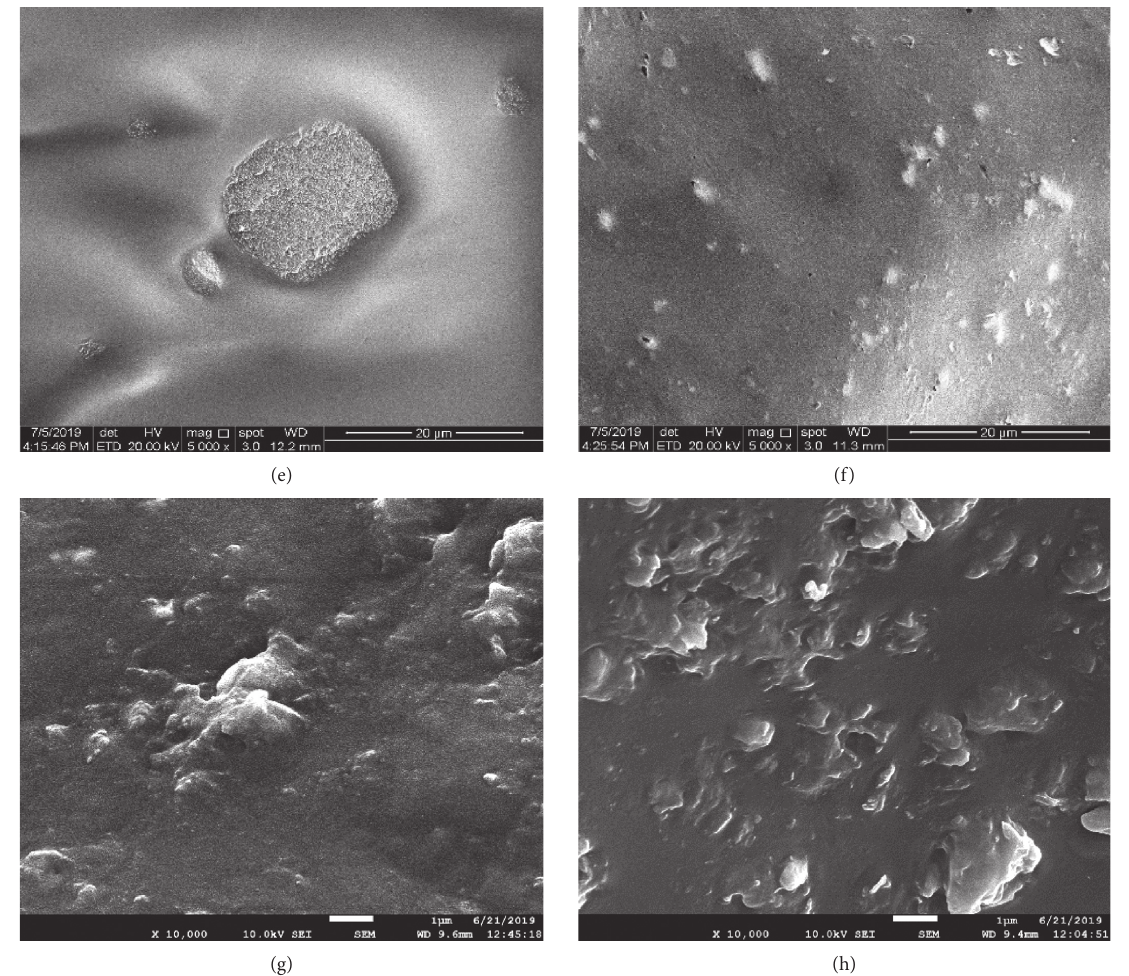
Figure 13: SEM images of the base asphalt and modified asphalt. (a) Nanocarbon particles (before surface modification). (b) Nanocarbon particles (after surface modification). (c) Base asphalt. (d) Rubber powder-modified asphalt. (e) Nanocarbon (before surface modification)- modified asphalt. (f) Nanocarbon (after surface modification)-modified asphalt. (g) Nanocarbon/rubber powder-modified asphalt. (h) Nanocarbon/SBS/rubber powder-modified